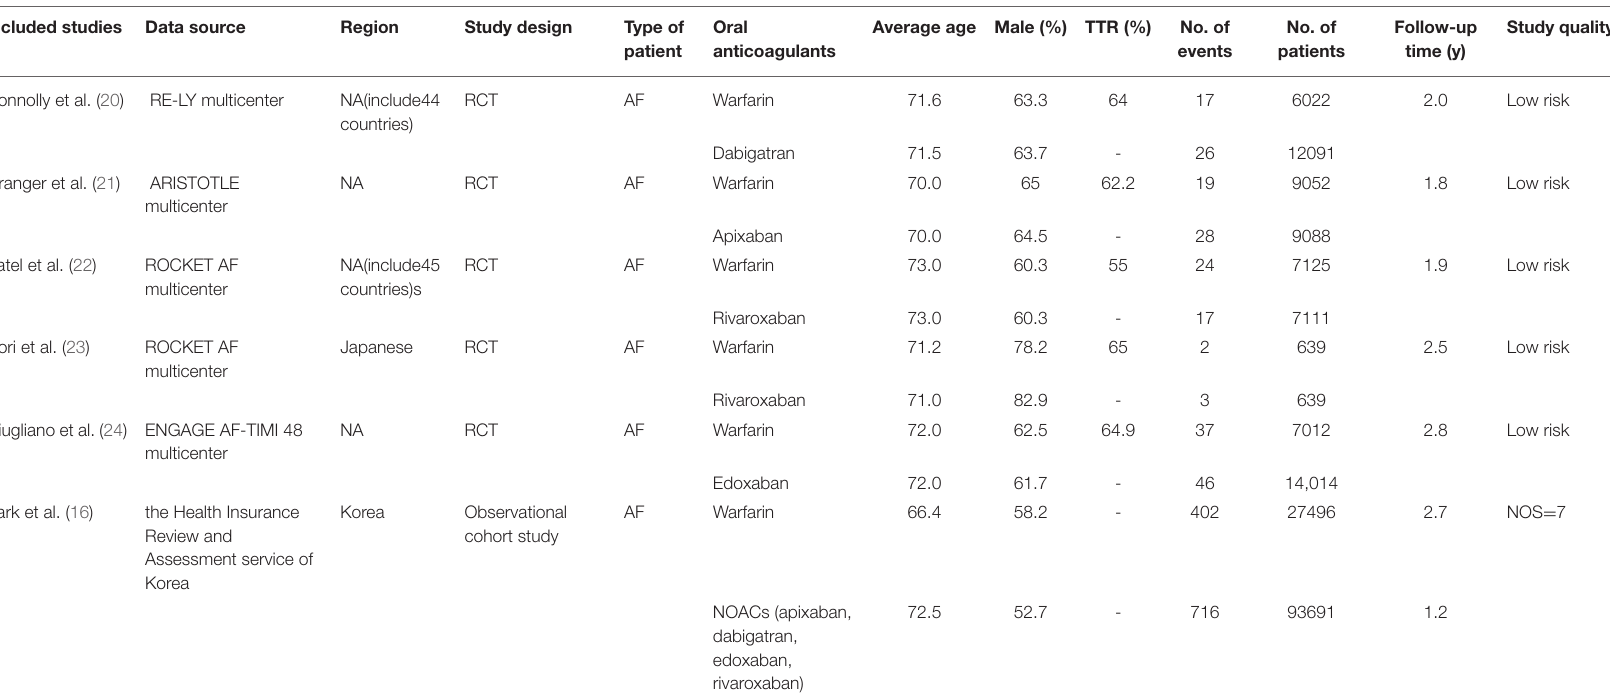
TABLE 1 | The baseline characteristics of the selected studies.